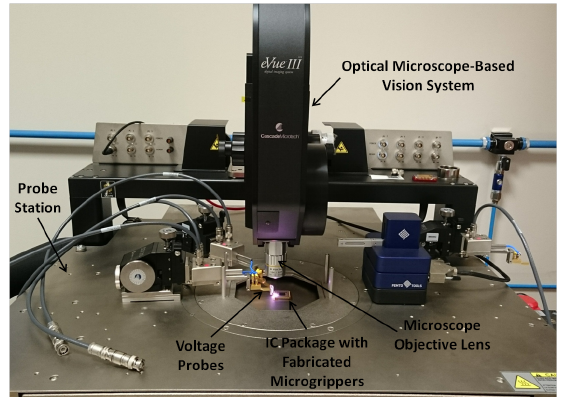
Figure 6. Experimental setup used to test the microgripper design variants fabricated with PolyMUMPs TM . The microgripper structures are mounted on an integrated circuit package and actuated with voltage probes on the Cascade Microtech probe station